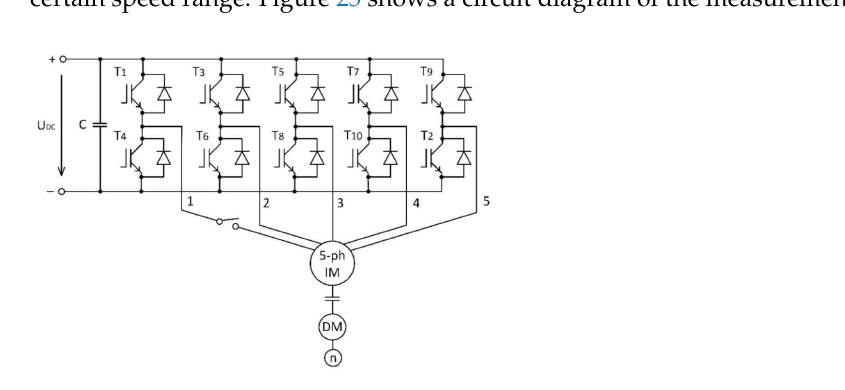
Figure 25. Principle circuit diagram for measuring the error states of a five-phase induction